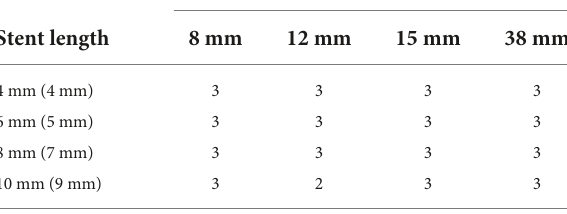
TABLE 1 Number of each stent size tested.